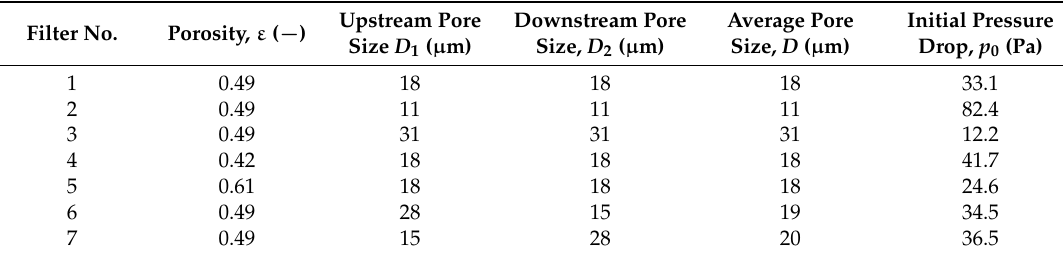
Table 1. Filter properties of seven